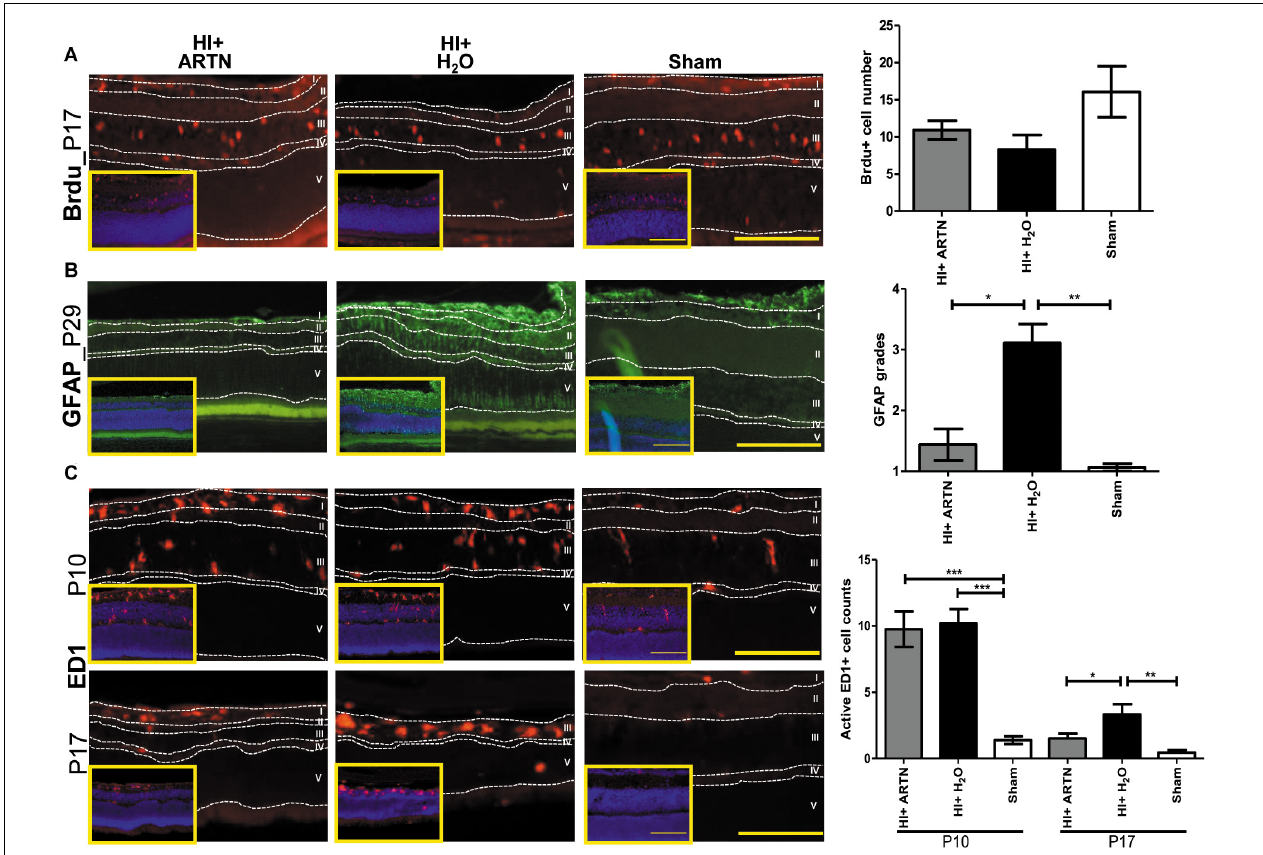
FIGURE 5 | Intravitreal injection of ARTN does not increase cell proliferation but decreases neuroinflammation and astrogliosis. (A) The representative figures showed that the Brdu + cells are mainly localized in the retinal ganglia cells (RGC, layer I) and inner nuclear layer (INL, layer III) at P17. There were no significant between-group differences in the Brdu + cell counts in the ARTN- and H 2 O-treated HI groups. (B) At P29, the H 2 O-treated HI group had marked GFAP immunostaining extending the whole retina. The GFAP immunostaining were significantly lower in the ARTN-treated HI group as compared to in the H 2 O-treated HI group by the semiquantitative analysis. There was no significant difference between the ARTN-treated HI group and sham controls. (C) Active ED1 + cells mainly localized in the layers I, II (inner plexiform layer, IPL) and III, but not in the outer plexiform layer (OPL, layer IV) and outer nuclear layer (layer V), after HI at P10. There were persistent prominently ameboid microglial cells in the layer III of the H 2 O-treated HI groups at P17. The cell counts were significantly increased in the ARTIN-treated and H 2 O-treated HI groups than sham controls at P10. The ARTN-treated HI group had markedly decreased active ED1 + cells, as compared with the H 2 O-treated HI group at P17. The insets showed the nuclear counterstaining with DAPI (blue). Scale bars: 100 µ m in main figures and insets; n = 5–16 per group in each time point, power = 0.8, * p < 0.05, ** p < 0.01, *** p <